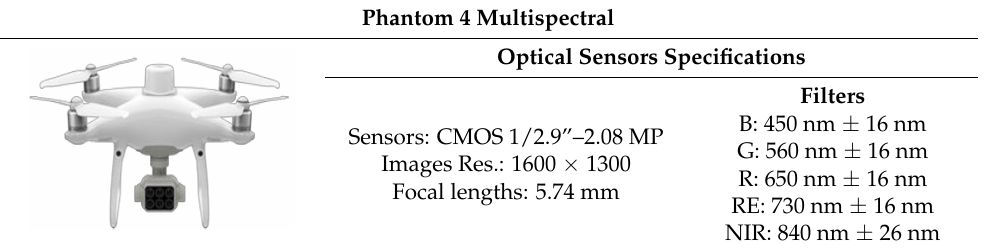
Table 1. Phantom 4 Multispectral